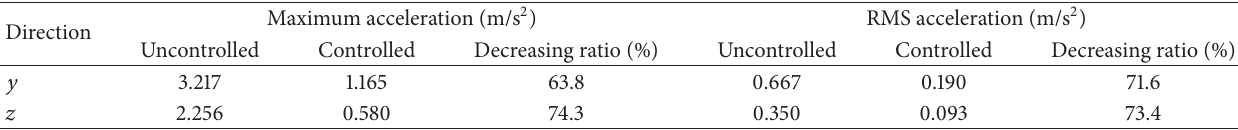
Table 6: Results for California earthquake.